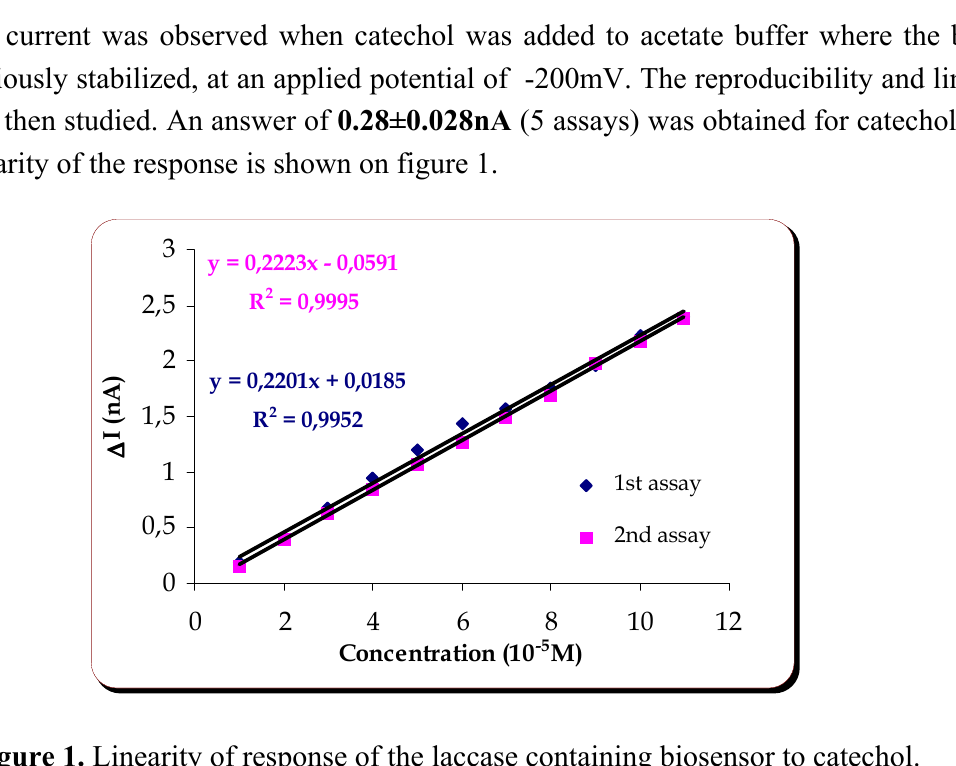
Figure 1. Linearity of response of the laccase containing biosensor to